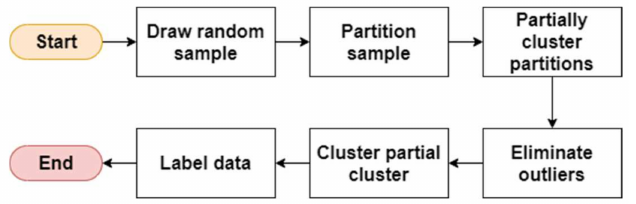
Figure 4. Basic steps of CURE